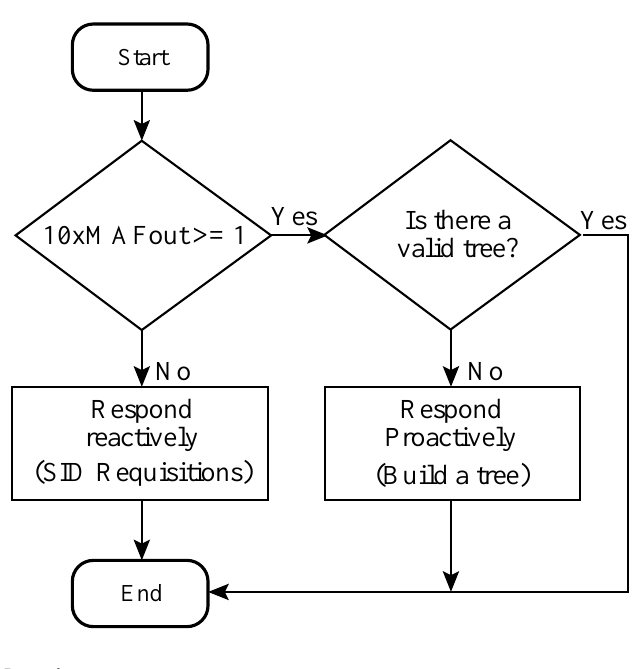
Figure 6. Multi-MAF’s adaptive